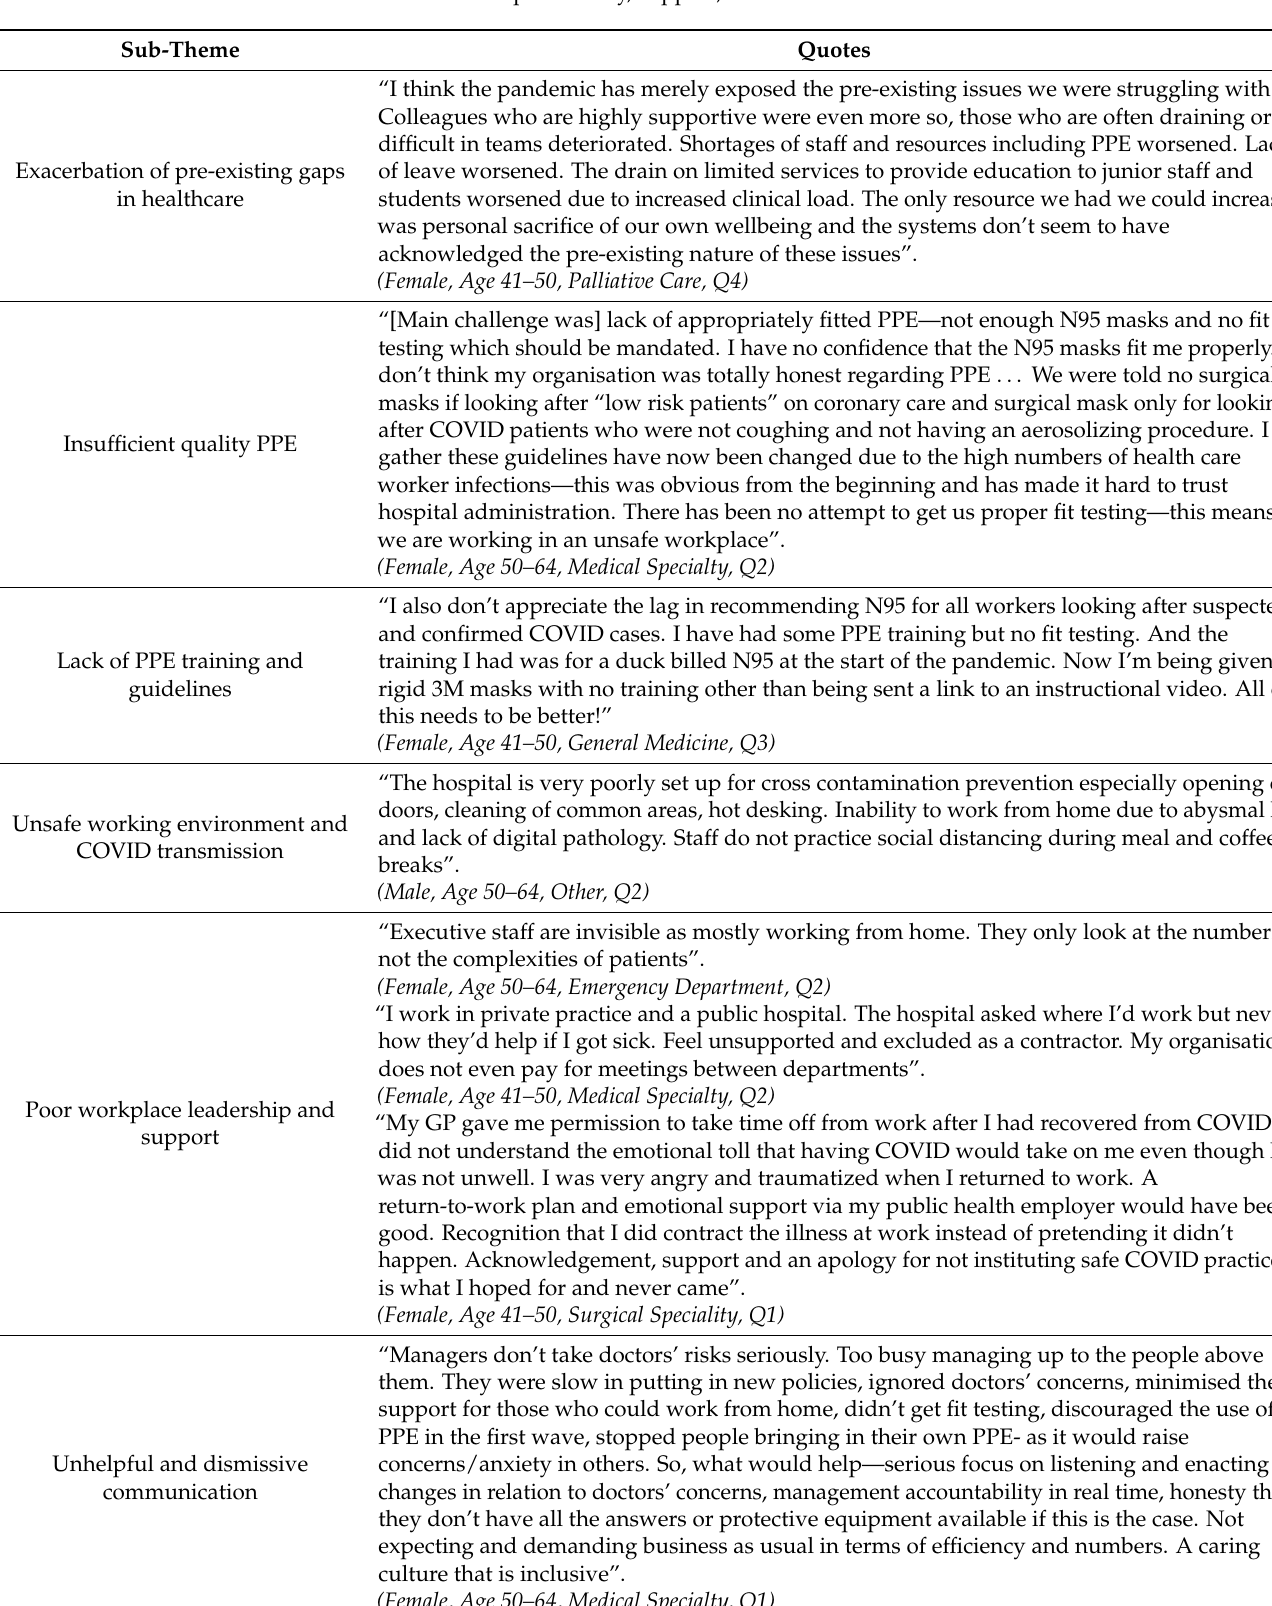
Table 4. Poor workplace safety, support, and